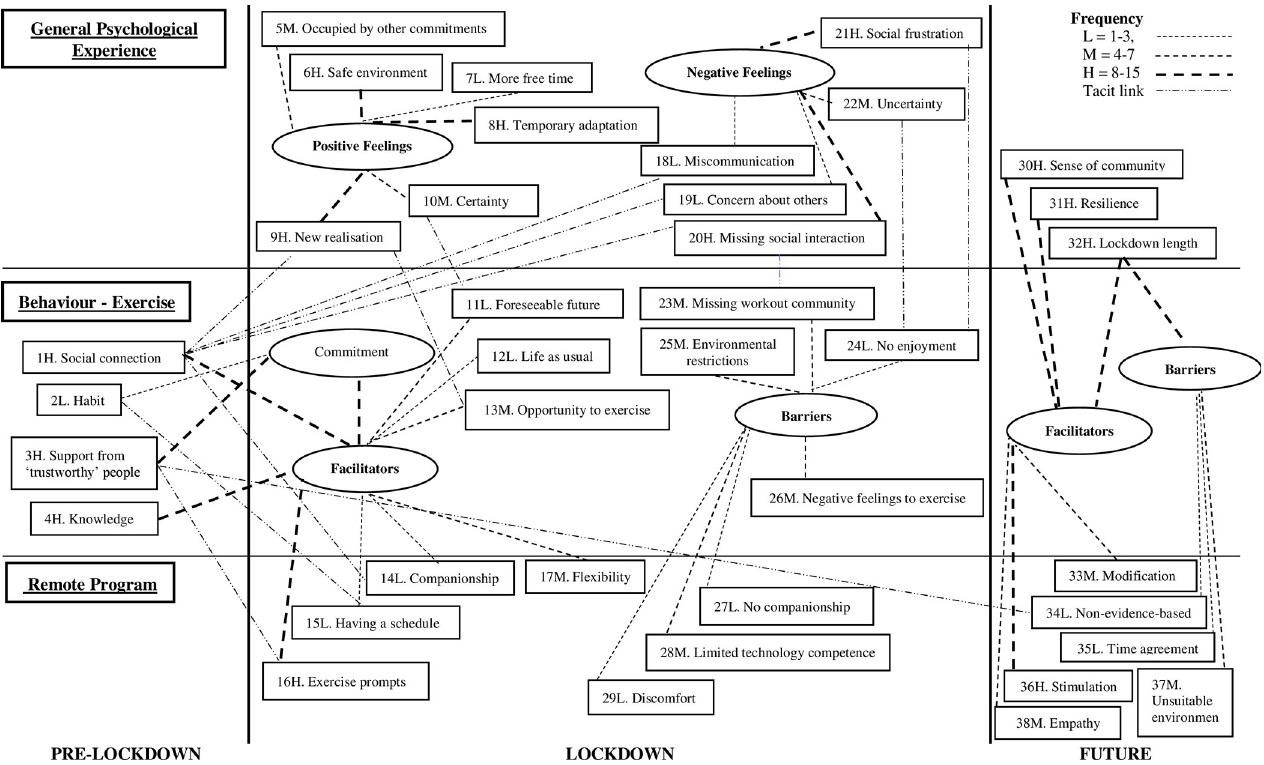
Fig 1. Chronological causal network: The influences on exercise behaviours and psychological responses before, during, and after the COVID-19 lockdown.